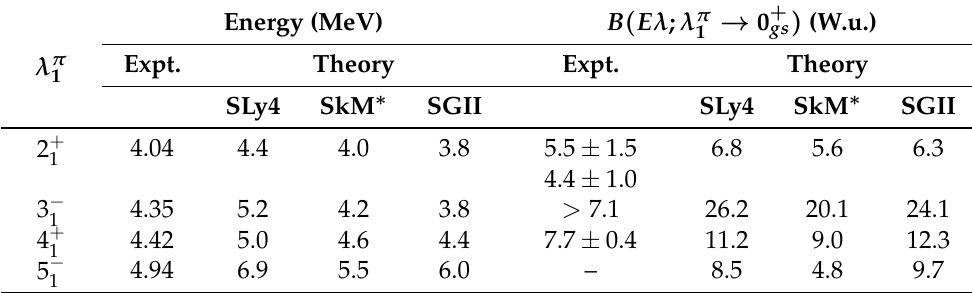
, 3 − , 4 + , and 5 − of 132 Sn using 1 1 1 1 → 0 + ) values are given in Weisskopf gs 1